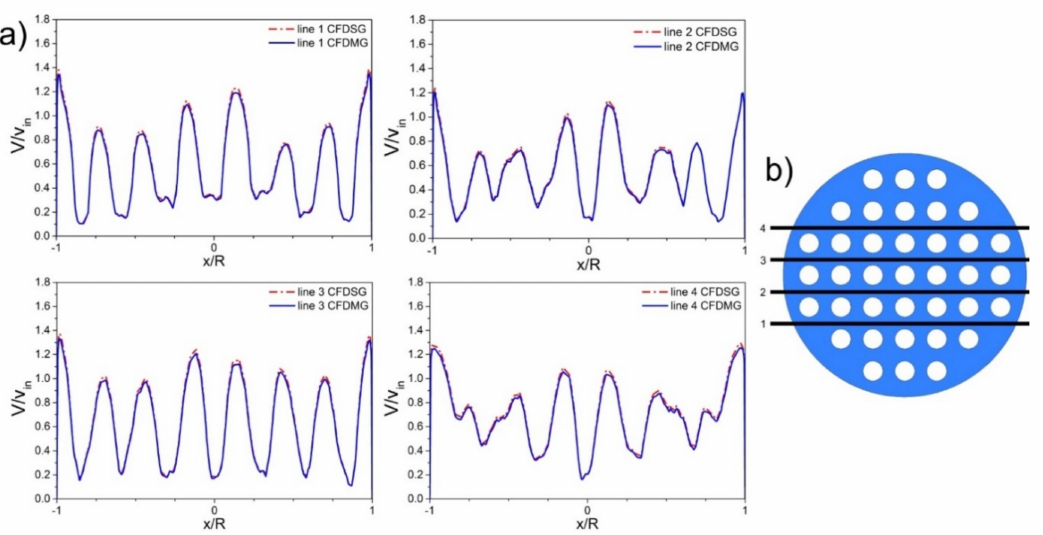
Figure 6. Comparison of velocity profiles for standard and modified tube bundle geometry. ( a ) Velocity profiles for Q = 5 m 3 / h; ( b ) location of the lines